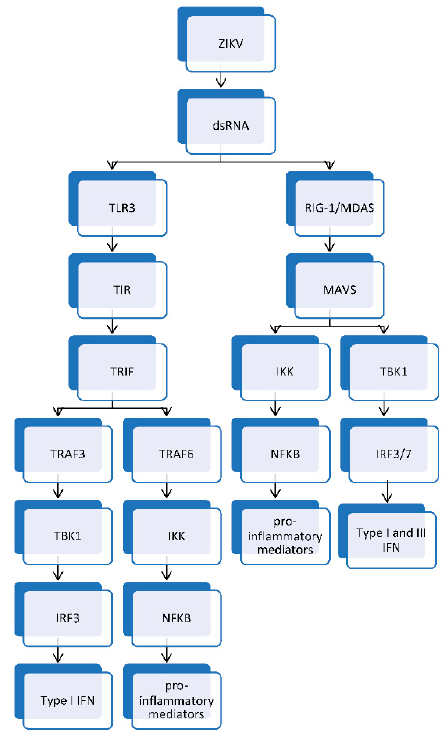
Figure 2. TLR3-mediated innate immune response yields type I IFN and proinflammatory media- tors. The RIG-I/MDA5 signaling pathway generates type I IFN, type III IFN, and proinflammatory